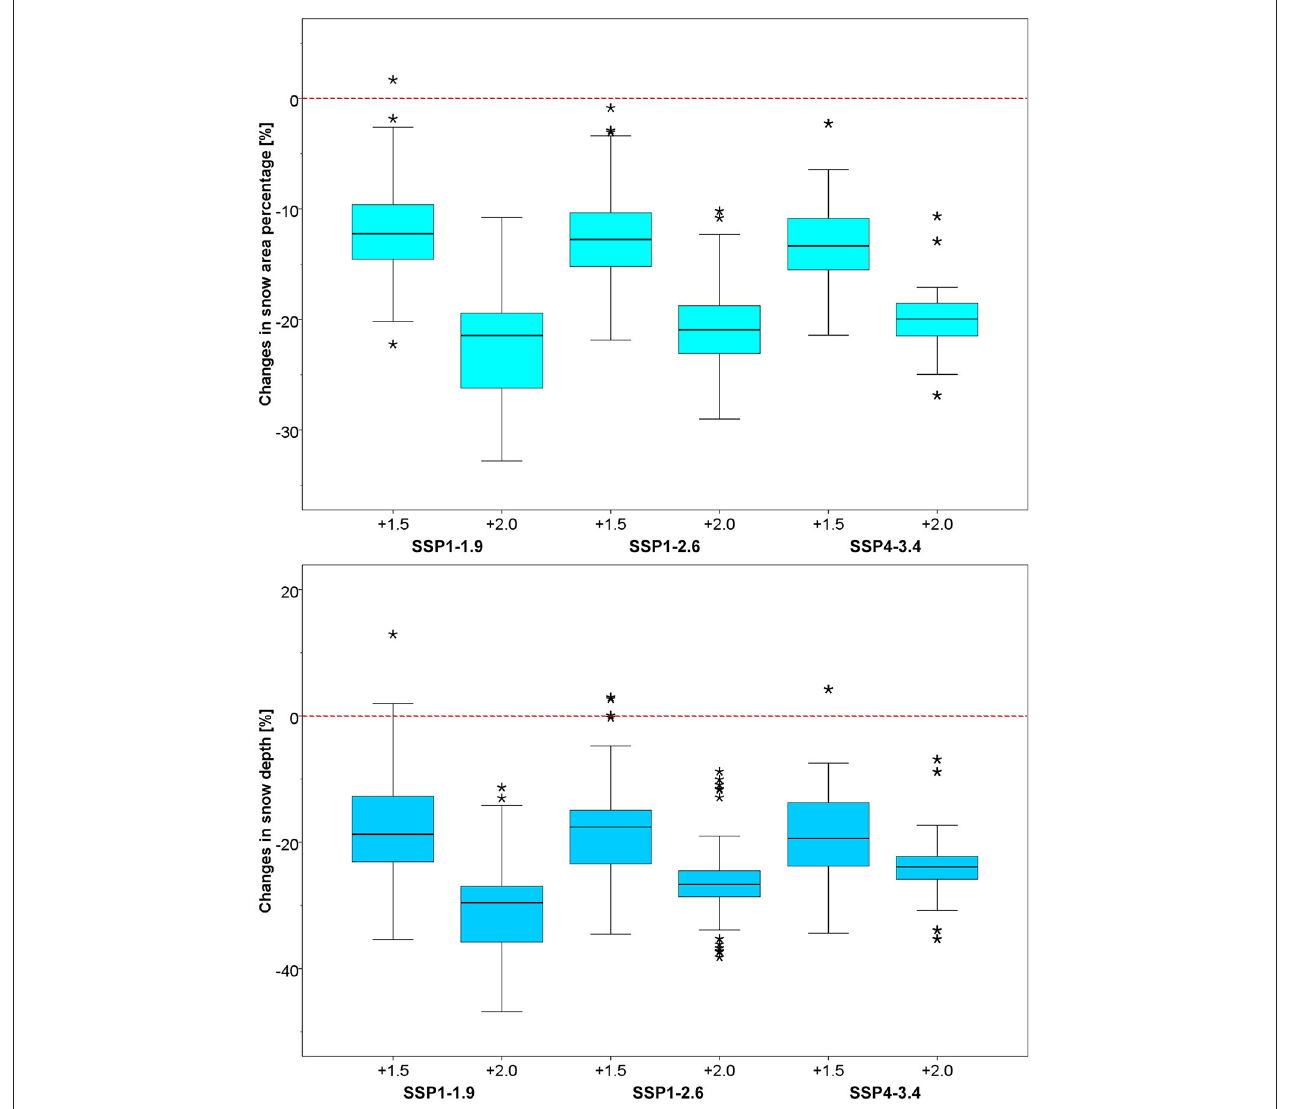
FIGURE 5 | Boxplot of the projected changes in snow area percentage (snc, upper panel) and snow depth (snd, lower panel), expressed as the percentage of change relative to the 1981–2010 baseline period, over the Andes domain. The changes are based on the periods where the temperature anomaly is projected to reach 1.5 and 2 ◦ C above preindustrial levels, considering the SSP1-1.9, SSP1-2.6, and SSP4-3.4 scenarios. Each boxplot shows the median and first and third quartiles, while the whiskers extend to the data values that are 1.5 times the interquartile range above or below the quartiles. Outliers are represented by